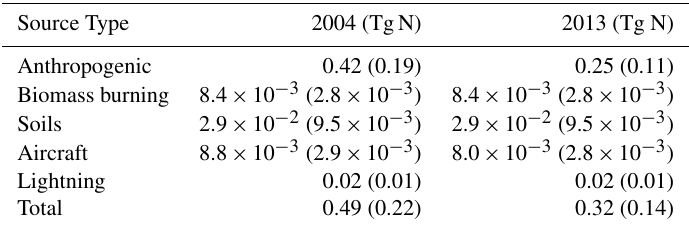
Table 1. Monthly averaged NO x emissions in July–August 2004 and 2013 over North America (25–50 ◦ N, 130–70 ◦ W) and over the South- east US (25–40 ◦ N, 100–75 ◦ W) in brackets from